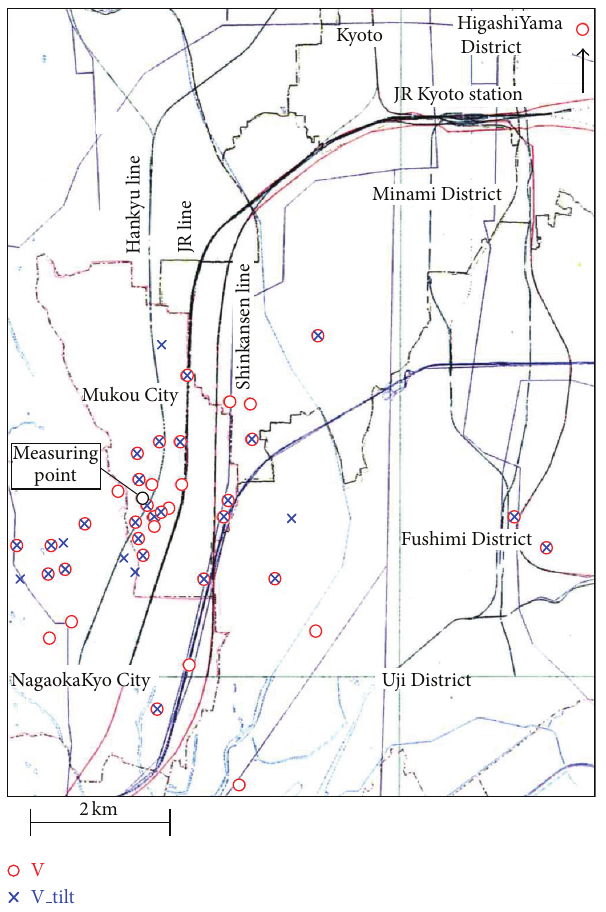
Figure 10: Distribution of IBSs when IRBS antennas are V antennas and V tilt antennas. Table 3: RZLR for four types of diversity antennas. Diversity antenna configuration